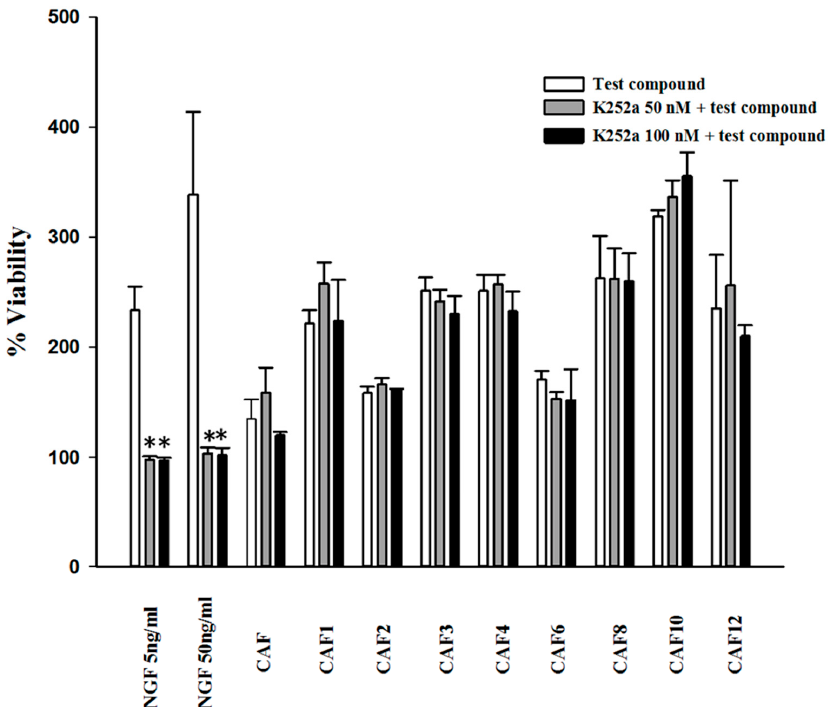
Figure 1. Effects of caffeic acid ester derivatives on the viability of serum-deprived PC12 cells in the presence of K252a. PC12 cells were seeded in 96-well plates deprived of serum and were treated with caffeate esters at 25 µ M, either separately or concomitant with K252a, a TrkA antagonist, at 50 and 100 nM. Cell viability was measured after 48 h using a 3-[4,5 dimethylthiazol-2-yl]-2,5-diphenyl- tetrazolium bromide (MTT) assay. The results are plotted as the percentage of cell survival compared to untreated cells and expressed as the mean ± standard error of mean (SEM). While the presence of K252a completely blocked the effect of nerve growth factor (NGF), it did not alter the viability increase induced by caffeic acid ester derivatives. * Significantly different from cells treated solely with NGF (5 or 50 ng/mL) ( p < 0.05). 3 PC12 cells were exposed to synthesized compounds separately or in addition to NGF (5 ng/mL) for 10, 30, and 60 min periods. The total cell protein was then extracted and subjected to